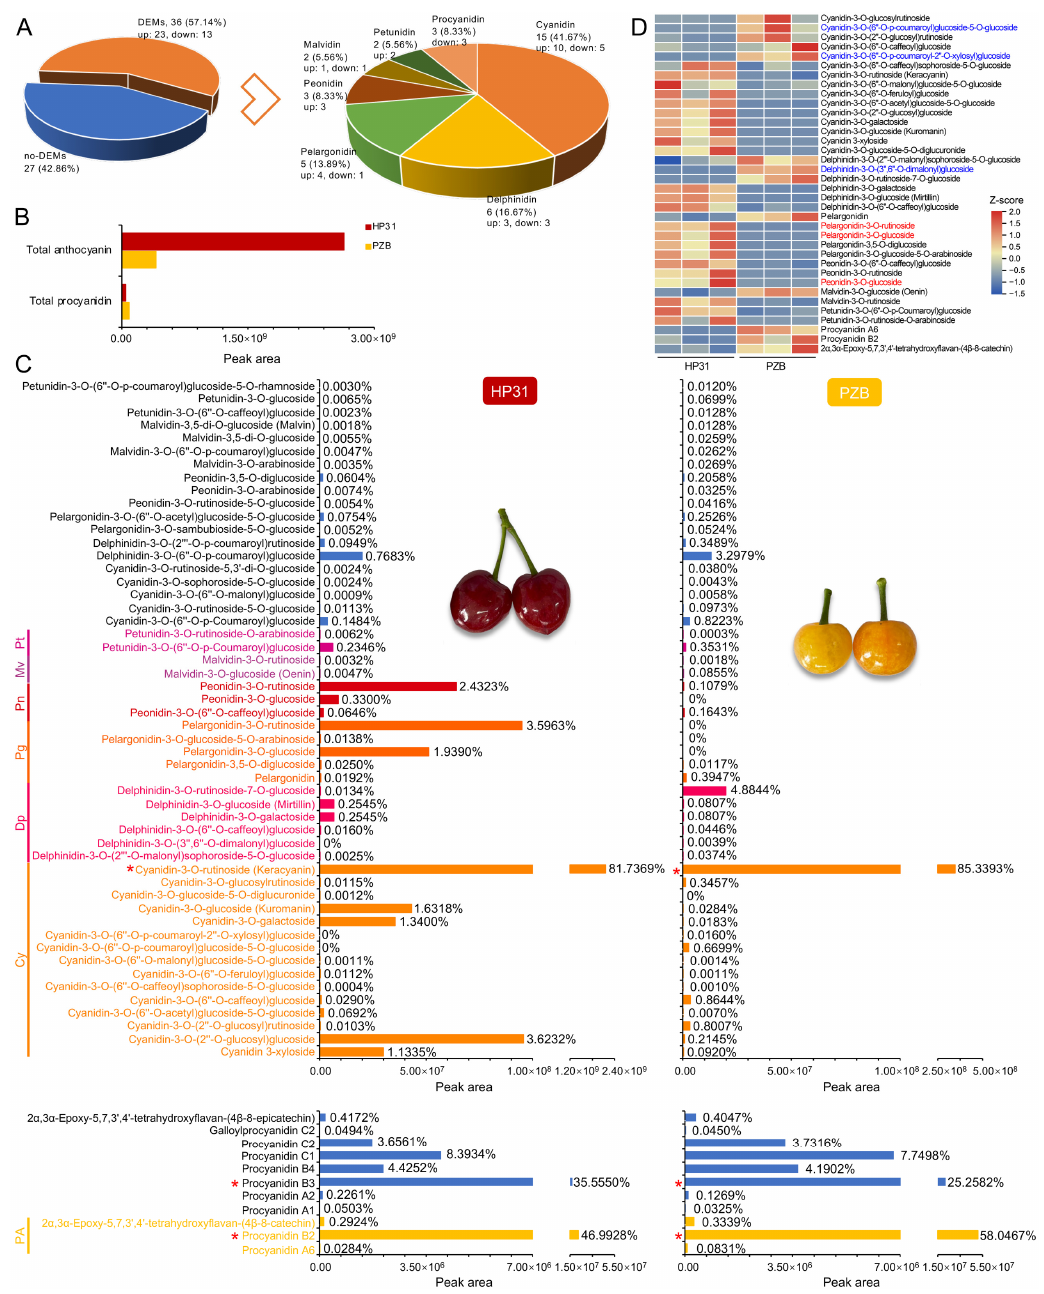
Figure 6. Comparison of anthocyanin and procyanidin compounds between dark-red and yellow fruits of Chinese cherry. ( A ) Type and number of differentially expressed metabolites. ( B ) The relative contents (peak area) of total anthocyanin and total procyanidin. ( C ) The relative contents and percentage of anthocyanin (upper) and procyanidin (lower) components in dark-red and yellow fruits of Chinese cherry. The blue font indicates the no-DEMs of procyanidins, and other colorful font indicates the 36 DEMs. Red asterisk indicates the predominant anthocyanin and procyanidin compounds. Abbreviations: Cy, cyanidin; Dp, delphinidin; Pg, pelargonidin; Pn, peonidin; Mv, malvidin; Pt, petunidin; PA, procyanidin. ( D ) Heatmap of the 36 DEMs. The color key from blue to red represents the relative content from − 1.5 to 2.0. Red and blue font color indicates the top three up-regulated and down-regulated anthocyanins in the yellow vs. dark-red